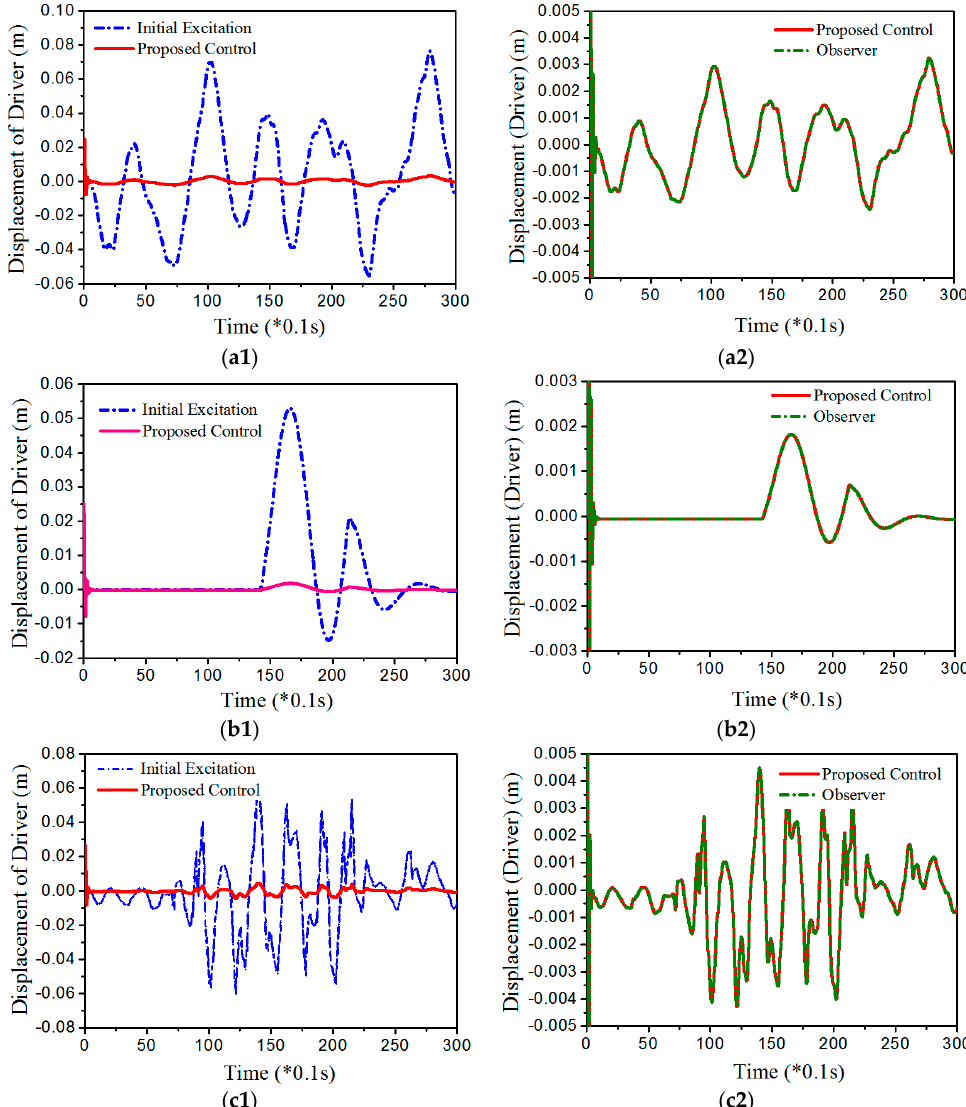
Figure 5. Simulation results of the displacement x 1 of the driver: ( a1 , a2 ) random-bump road; ( b1 , b2 ) regular-bump road; ( c1 , c2 ) random step wave road.